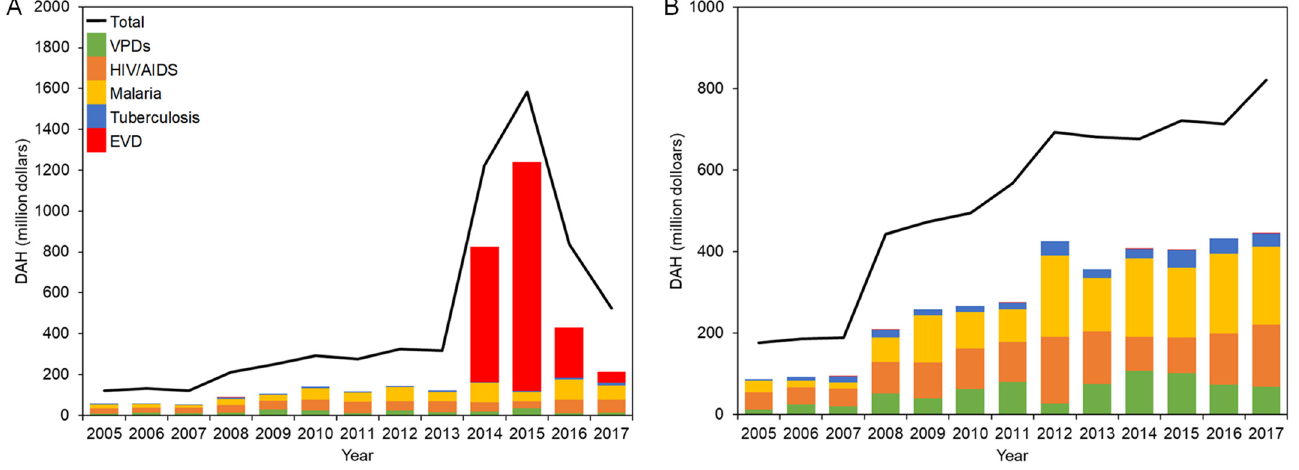
Figure 1. DAH for EVD-affected countries in 2005–2017: ( A ) West Africa; ( B ) DRC. In 2005, the total DAH for West Africa was USD 121 million, and the two dominant categories, HIV/AIDS (22.8%) and malaria (16.5%), were followed by VPDs (5.6%). While minor decreases were observed in 2011 and 2013, there was an upward tendency of total DAH on the whole, which exceeded USD 300 million in 2012, and HIV/AIDS and malaria continuously comprised the larger proportion. It quickly soared to USD 1.22 billion in 2014 and finally peaked at USD 1.58 billion in 2015 before plummeting to USD 525 million in 2017, due to a surge of DAH for EVD from USD 662 million in 2014 to USD 1.12 billion in 2015, which constituted 70.7% of total DAH for that year.